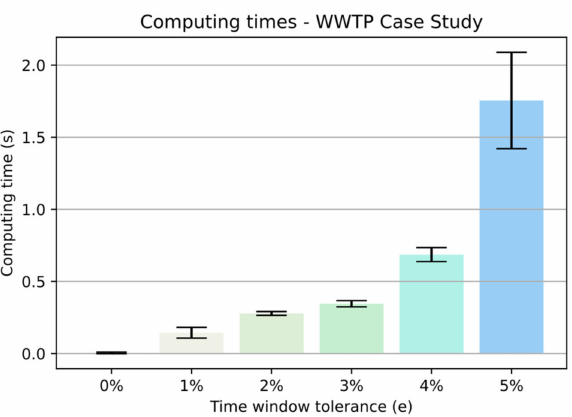
Figure 9. Computing times under several tolerance factor values. WWTP case